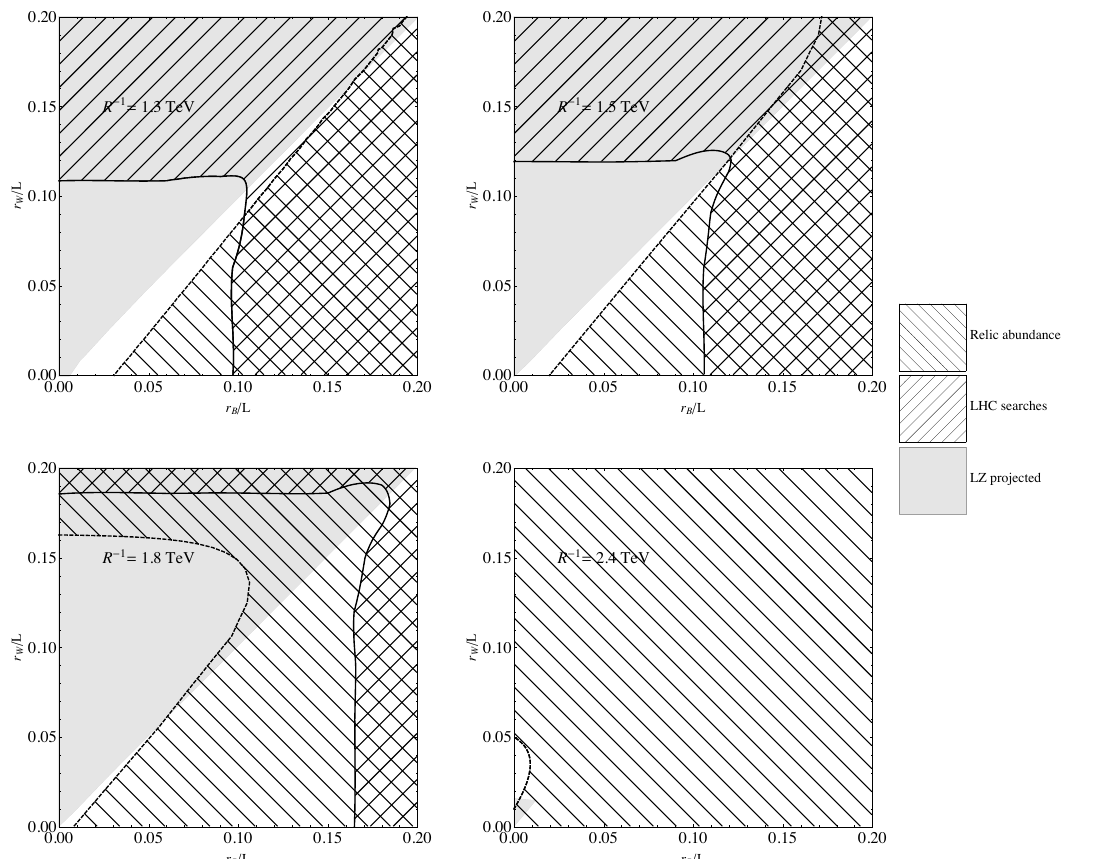
Figure 10 . Combined constraints from relic abundance (left hatched), LHC collider search (right hatched) and LZ projected direct detection sensitivity (grey shaded) for R (cid:0) 1 = 1 : 3 ; 1 : 5 ; 1 : 8 ; 2 : 4 TeV in ( r B =L; r W =L ) plane. The solid curves are limits from LHC collider search and the dashed curves are limits from relic